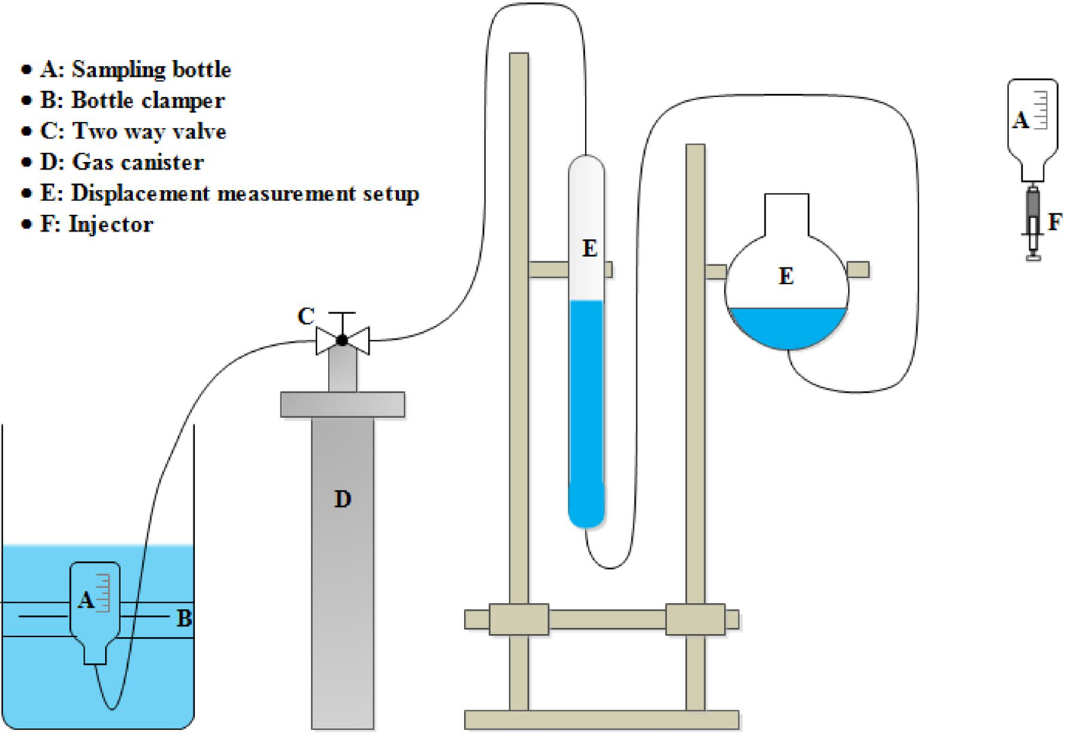
Figure 2. Set up for gas content